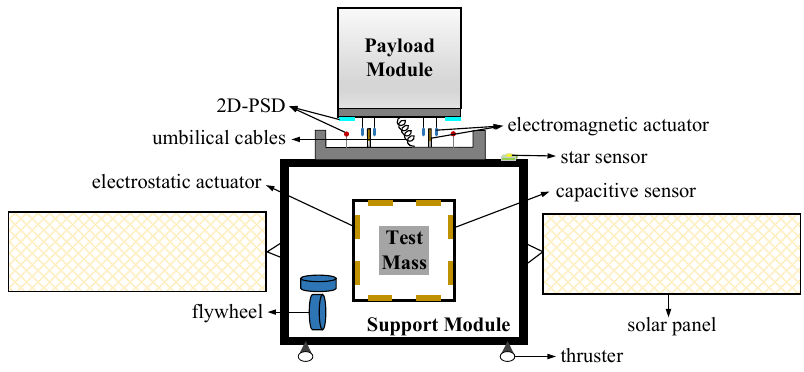
Figure 1. Improved DFP spacecraft architecture. DFP, disturbance-free payload.